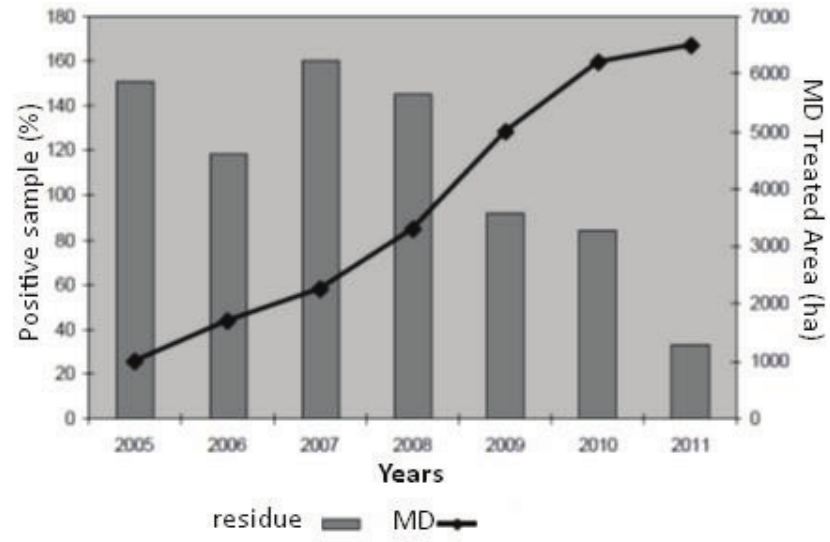
Figure 3 Percentage samples with insecticide/acaricide (gray bars) and area treated (ha) with mating disruption (black line) in